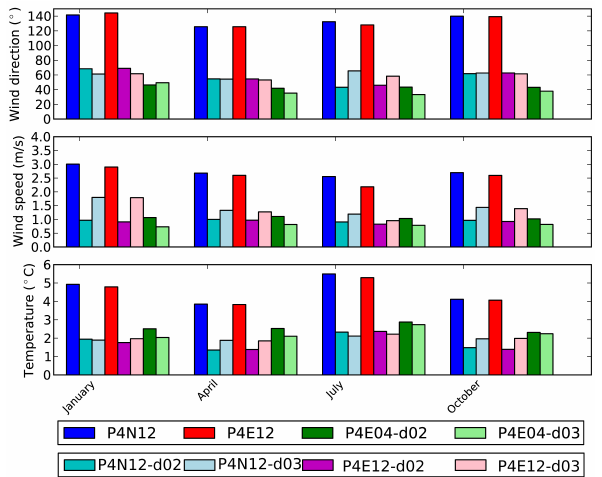
Fig. 4. Domain-wide RMSE of the bi-hourly difference between WRF simulated temperature, wind speed and wind direction and the METAR measured data for January, April, July and October 2009 for domains d01 (12km resolution, California), d02 (4km resolution, San Diego) and d03 (4km resolution, San Francsico). The RMSE for the domains d02 and d03 using the 12km resolution simulation are plotted in cyan and magenta, and in light blue and pink respectively.